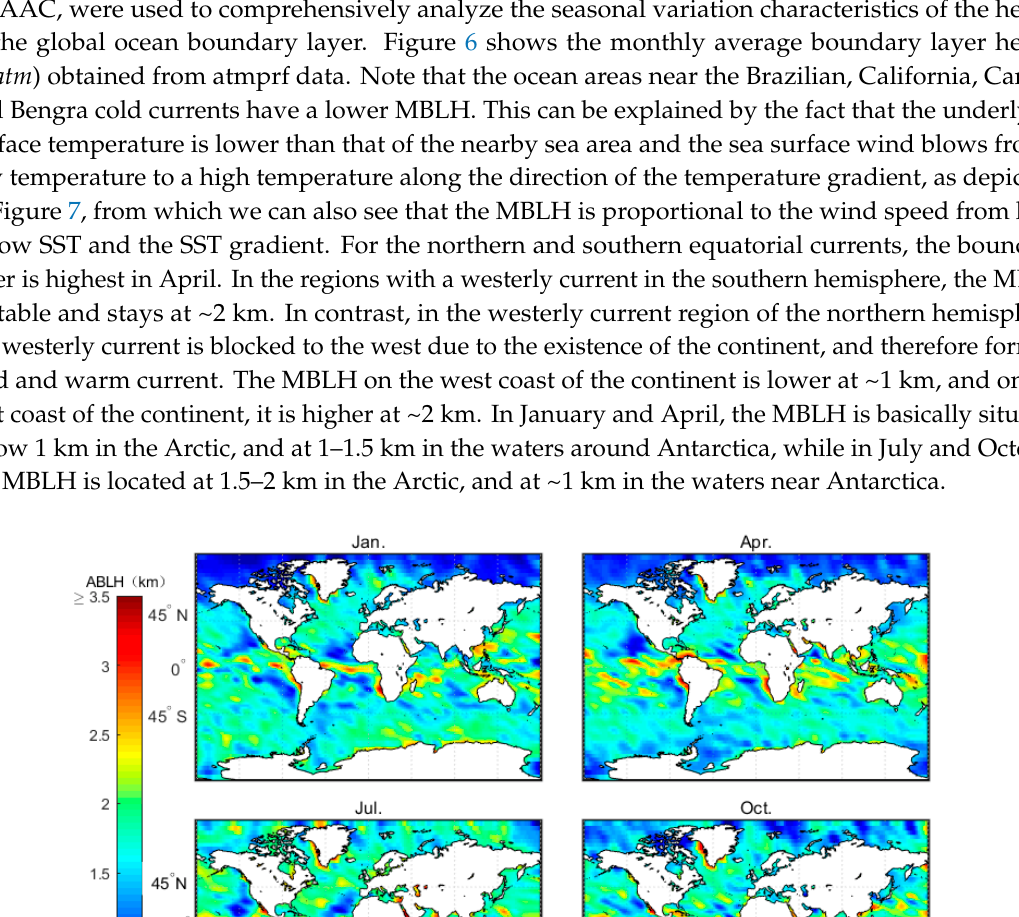
Figure 7. The perennial average monthly wind-driven current represented by the monthly mean sea surface temperature field and wind field. Figure 8 shows the monthly average boundary layer height ( _ h ech ) obtained from echprf data. Note that the MBLH reaches a height of 3 km in January and April, especially in the area of westerly ocean current in the southern hemisphere. On the contrary, the MBLH is lower in July and October than the heights observed in January and April. With the exception of the region of westerly ocean currents where the MBLH can reach 2.5 km during the months of July and October, the MBLH remains below 2 km in all the remaining regions. The explanation for this phenomon is as follows. In winter, the ocean surface is warm, and thus the water vapor rises and releases latent heat at a certain height. This results in the formation of the strongest inversion layer produced throughout the four seasons [17], which pushes the MBLH higher. In contrast, during summer, the ocean surface